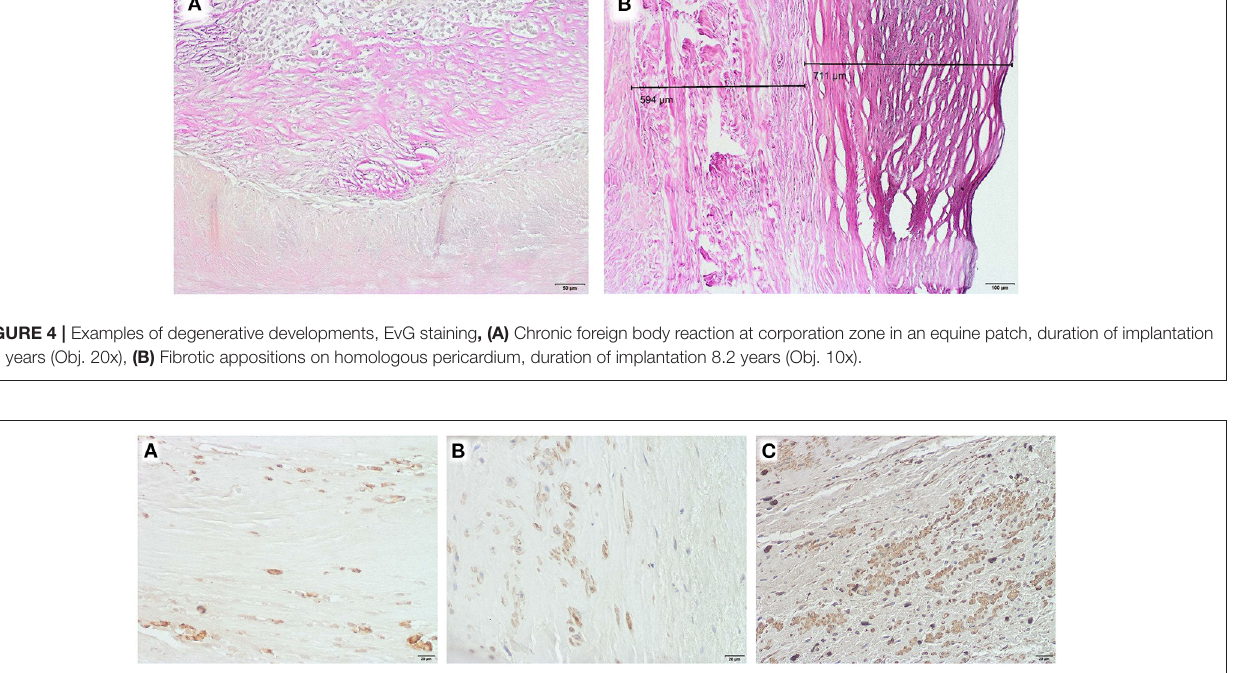
FIGURE 5 | Inflammatory cells in selected explants, Obj. 40x, (A) CD 3 positive cells in an equine patch, duration of implantation 5.2 years, (B) CD 20 positive cells in autologous pericardium, duration of implantation 4 years, (C) CD 68 positive cells in autologous pericardium, duration of implantation 8.2